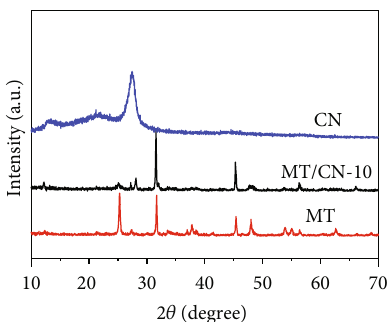
Figure 1: XRD patterns of pure CN, MT, and MT/CN-10 Z-scheme heterojunction